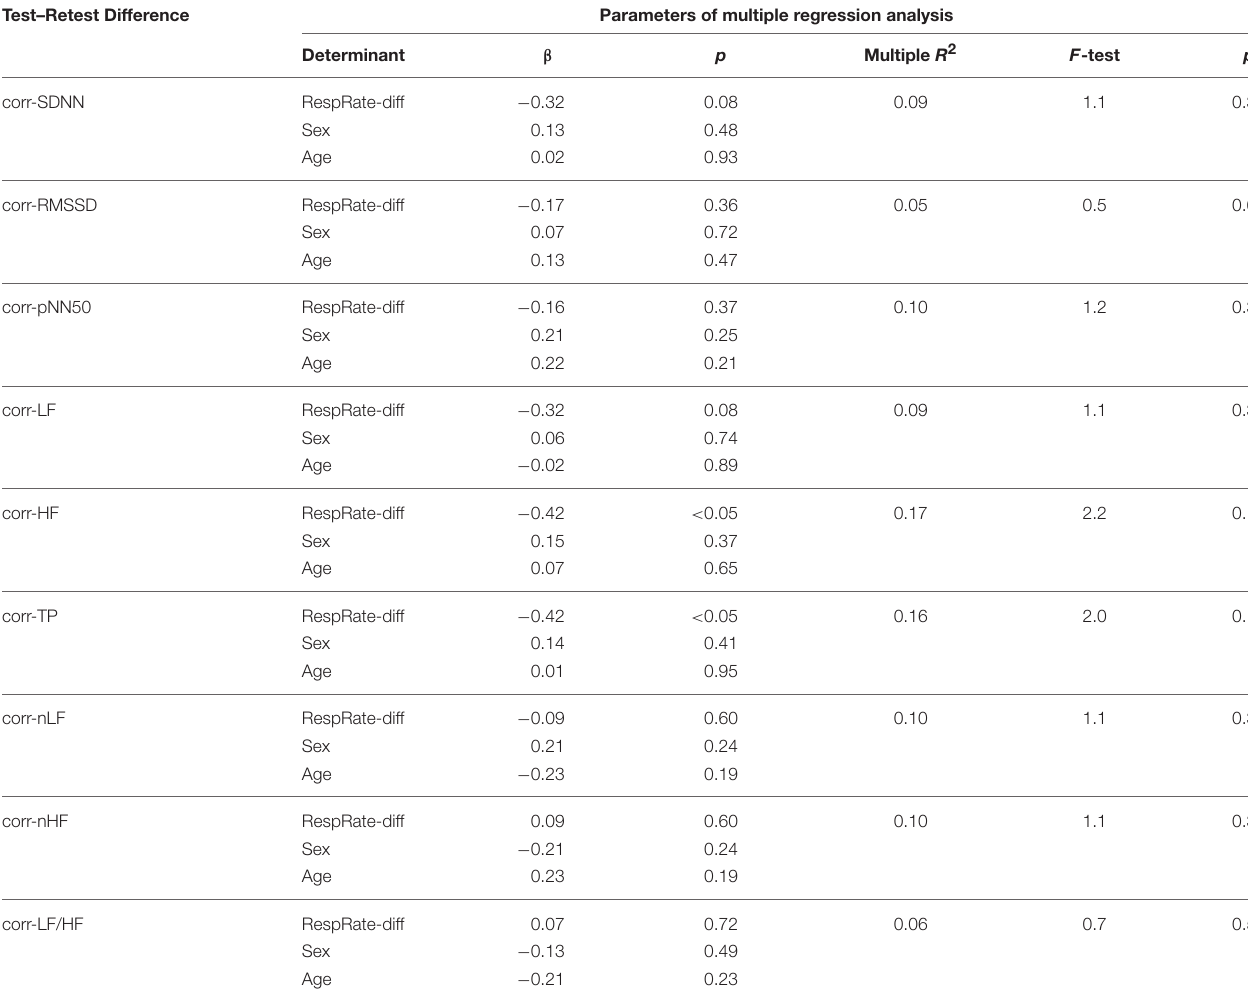
TABLE 3 | Results of the multiple regression analysis considering differences in respiratory rate (RespRate-diff), sex and age as determinants of differences between Test and Retest in corrected HRV parameters. Test–Retest